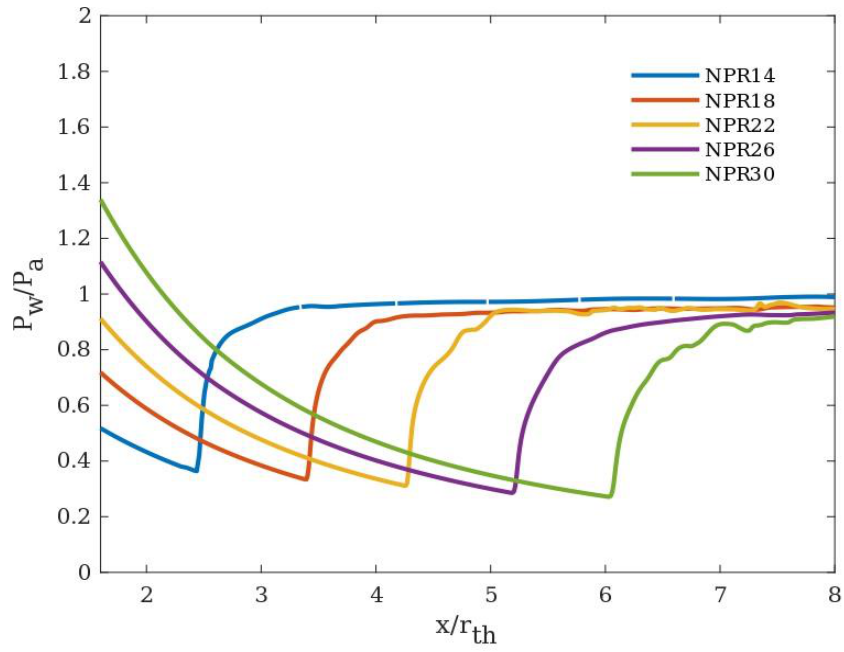
Figure 5. Wall pressure distribution at different NPRs (To = 300 K).